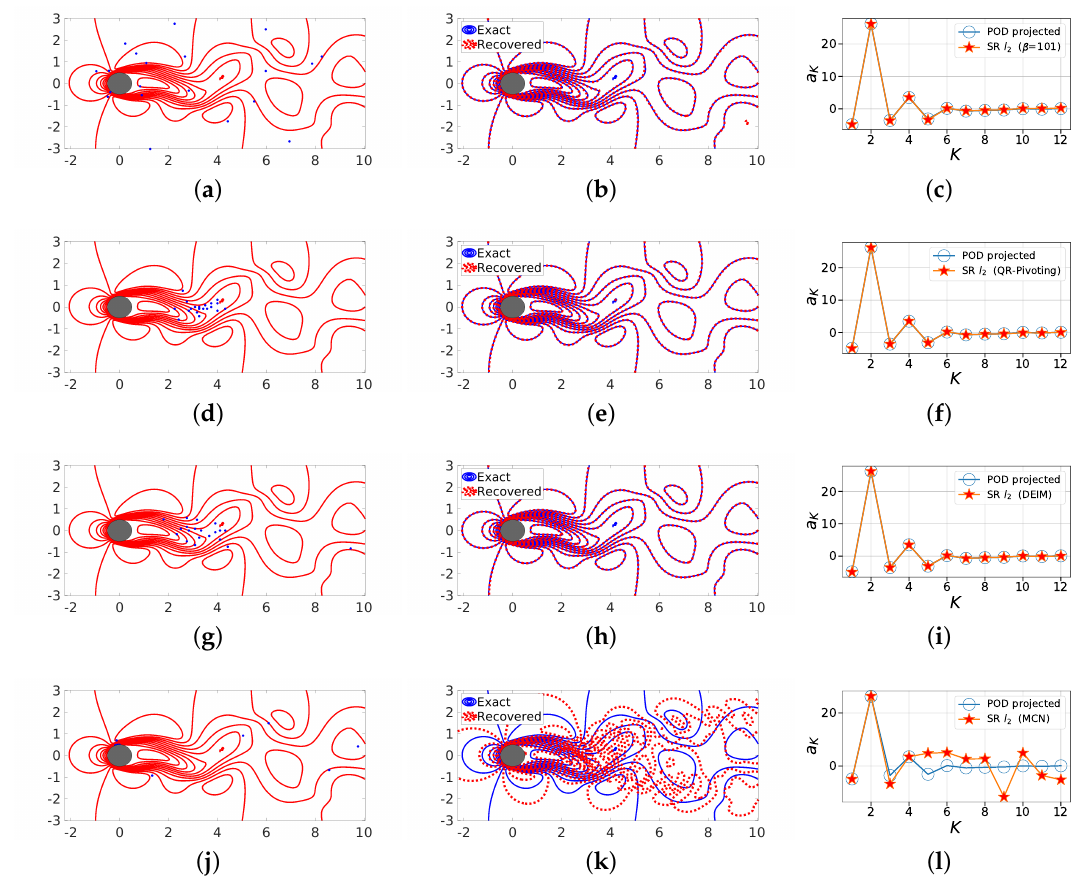
Figure 16. Dissection of instantaneous snapshot reconstruction for a highly oversampled case ( K ∗ = 6, P ∗ = 10). The figure shows the different sensor locations, namely random sensors with seed β = 150 ( a ), QR factorization with column pivoting ( b ), DEIM ( c ) and minimum condition number (MCN) ( d ) along with the corresponding overlaid true and reconstructed solutions ( b , e , h , k ), and the recovered coefficients a ( c , f , i , l ) using POD-based SR for Re = 100. The corresponding error quantifications for the above cases are as follows. First row: (cid:101) 1 = 5.73 × 10 − 2 and (cid:101) 2 = 3.43. Second row: (cid:101) 1 = 3.01 × 10 − 2 and (cid:101) 2 = 1.80. Third row: (cid:101) 1 = 1.98 × 10 − 2 and (cid:101) 2 = 1.19. Fourth row: (cid:101) 1 = 9.77 × 10 − 1 and (cid:101) 2 =